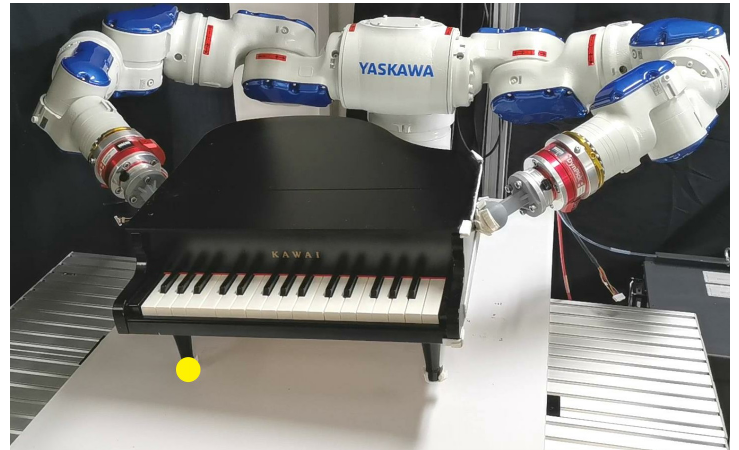
Figure 1. A dual-arm robot manipulates a piano by pivoting on the object’s vertex (marked by a yellow dot).